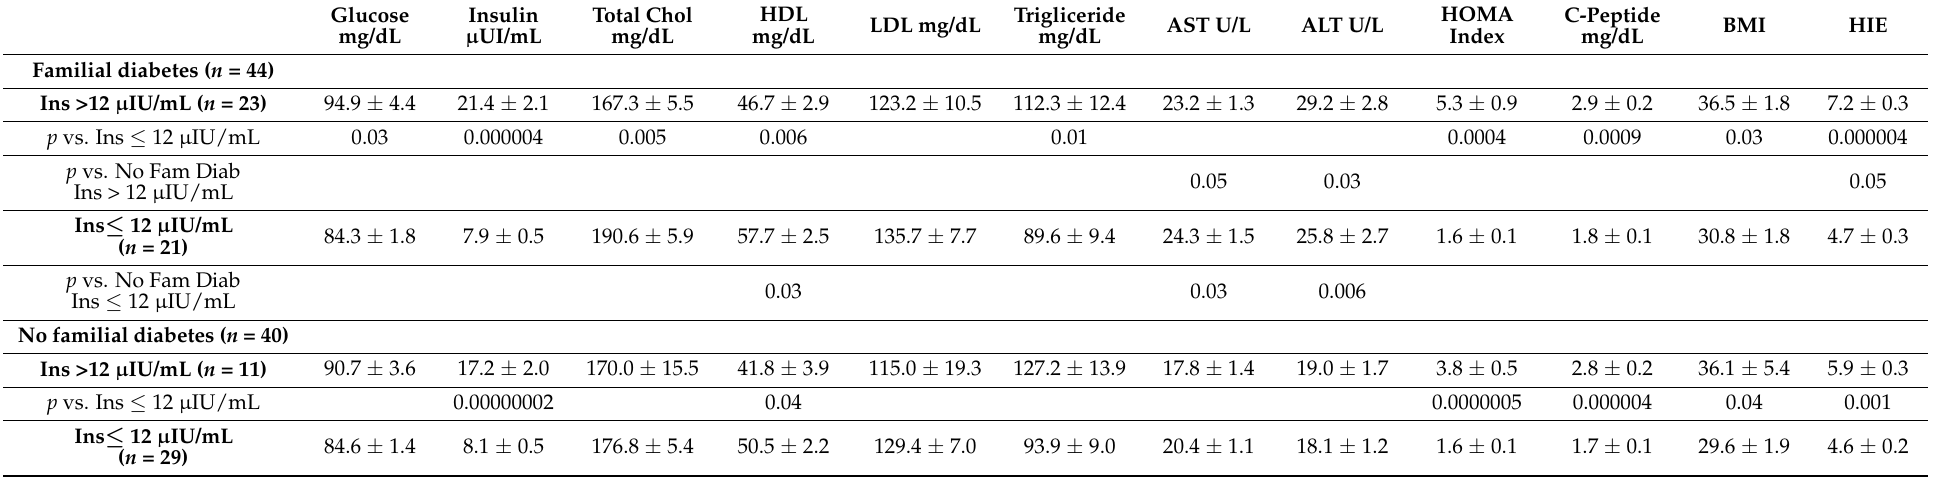
Table 2. Metabolic parameters of women with PCOS and overweight/obesity selected for the study ( n = 84) according to baseline insulin levels ≤ 12 or > 12 µ